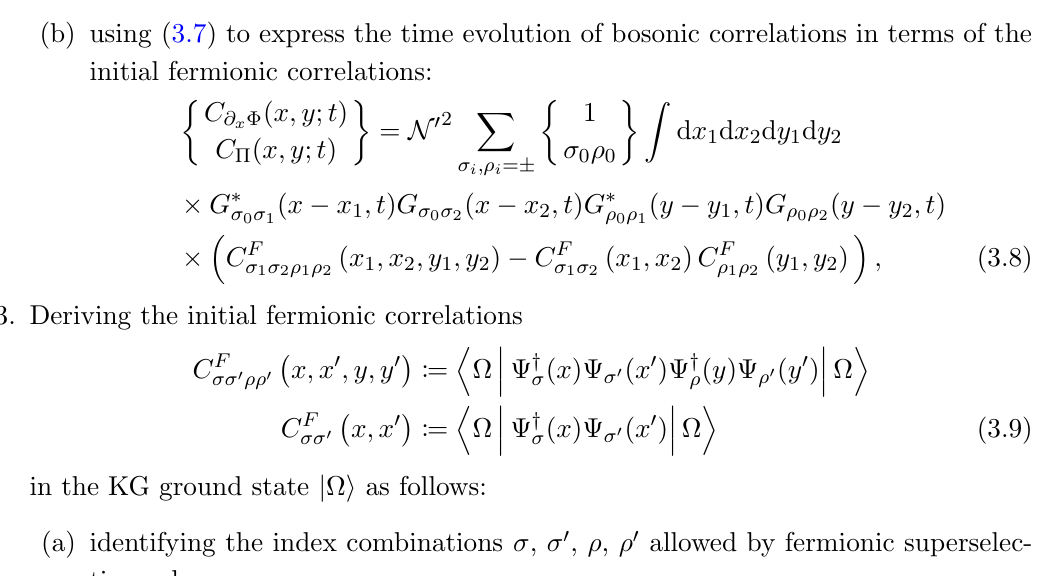
Figure 2 . The analytical results for the correlations of (cid:5) and @ x (cid:8) under SG dynamics at (cid:12) = for PBC. Density plot of (cid:5) ( top ) and @ x (cid:8) ( bottom ) correlations as function of distance x and time t (in units 1 =M ). Initial correlations have been subtracted as in (cid:12)gure 1. The initial state is the KG ground state with mass m 0 and the post-quench soliton mass is M = 2 : 5 m 0